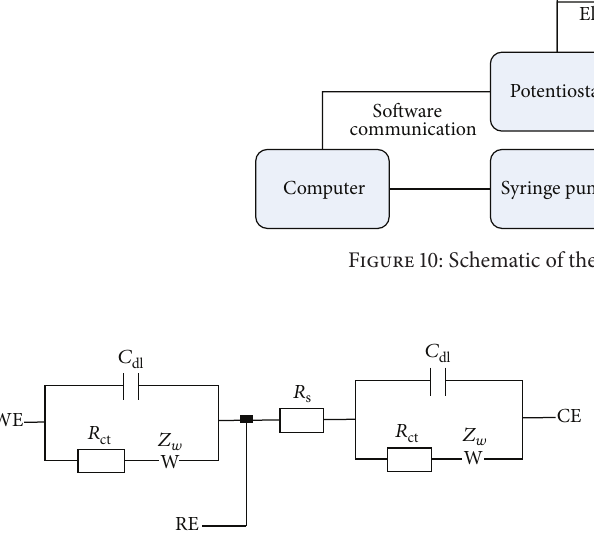
Figure 11: Randles equivalent electrical model of an electrochemical